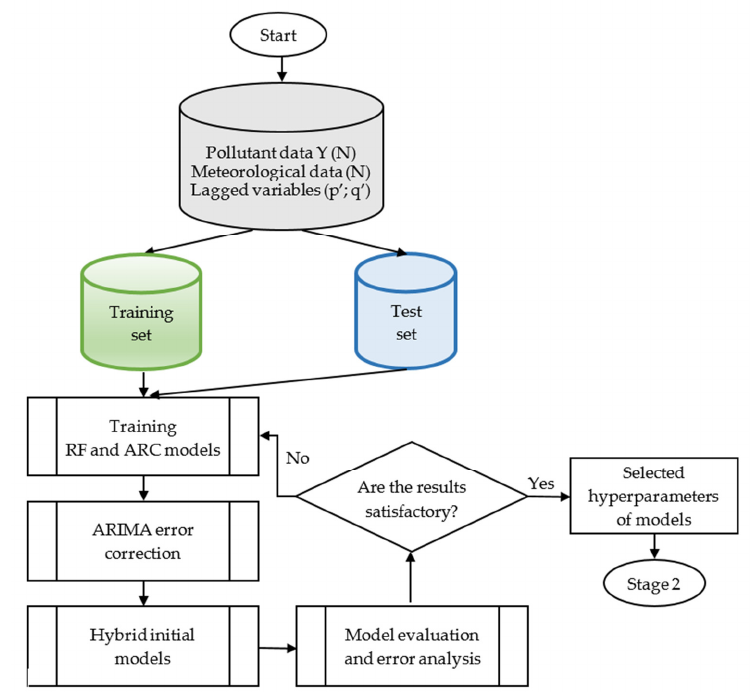
Figure 1. Flowchart of the algorithm of stage 1: Generating initial hybrid models. Stage 2: Multi-Step Ahead Forecasting